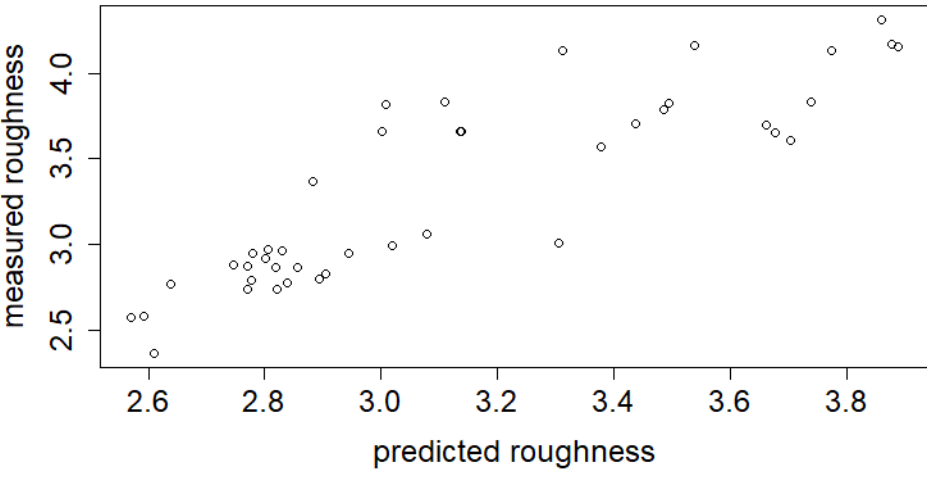
Figure 3. Scatter plot for predicted and actual values in test set for